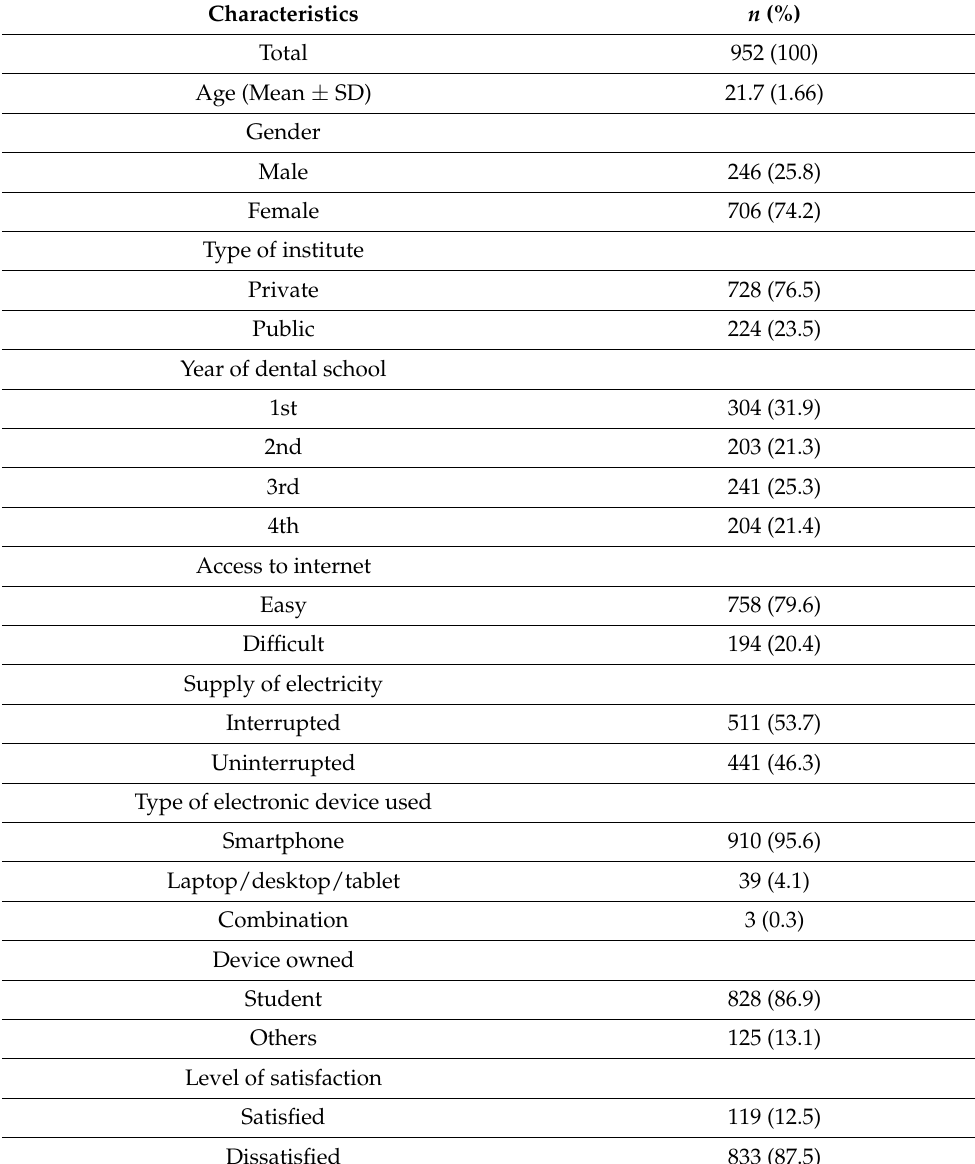
Table 1. Characteristics of the study